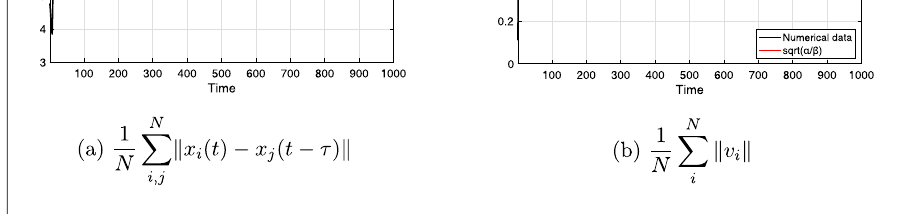
Figure 6 The average distance between agents and the velocity of agents for Case I and t ∈ [0,1000]. Panel ( a ) shows the comparison of the average distance between agents with the value lr the average velocity of agents compared with the value